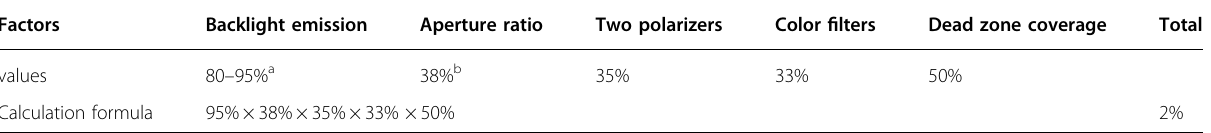
Table 1 Total light transmission (TLT) calculation of an LC panel for VR headsets